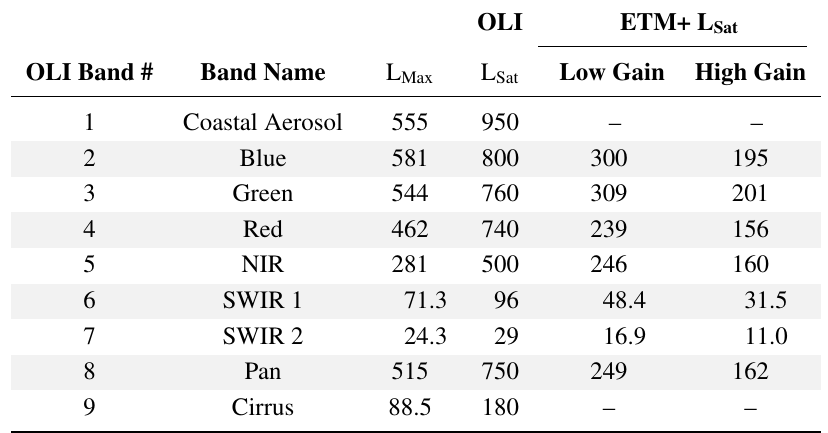
Table 5. Saturation (L per band.